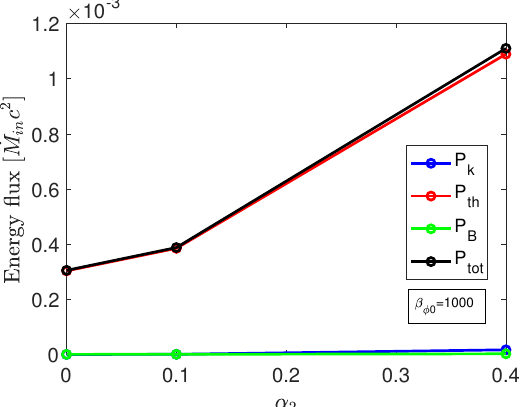
Figure 3. Bernoulli parameter in unit of v 2 pressure at the midplane.